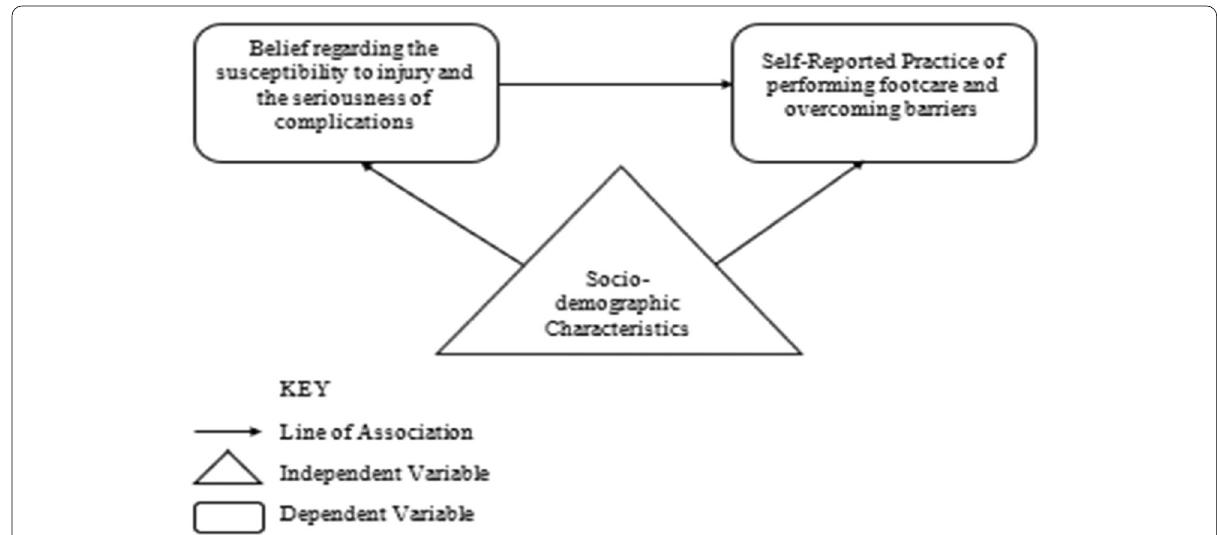
Fig. 1 A modified Health Belief Model for diabetic